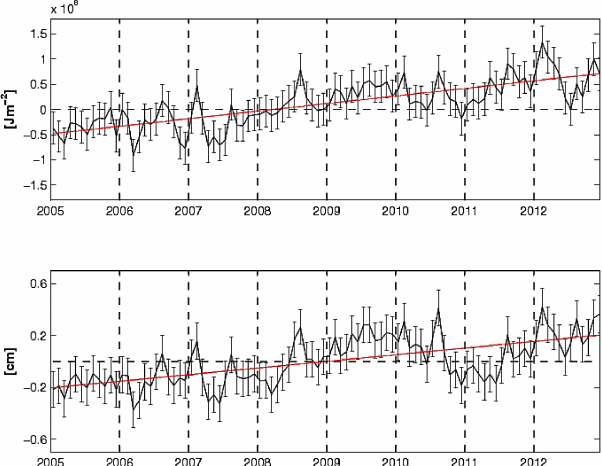
Figure 1. Global ocean (60 ◦ S–60 ◦ N) heat content (upper, GOHC) and steric sea level (lower, GSSL) during the period 2005–2012 from Argo according to the method of von Schuckmann and Le Traon (2011). The 8-year trends (red line) of GOHC/GSSL account for 0.5 ± 0.1Wm − 2 , and 0.5 ± 0.1mmyear − 1 for the 10–1500m depth layer, respectively. Error bars include data processing and cli- matology uncertainties, but not systematic